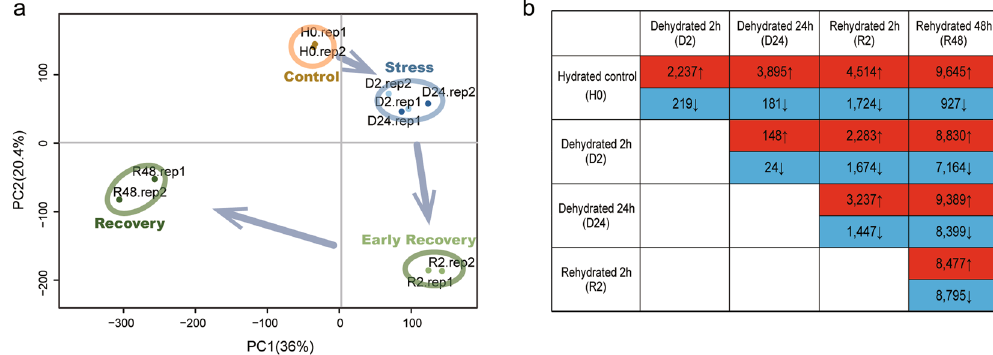
Figure 1. Global gene expression characteristics of Bryum argenteum during dehydration and rehydration. ( a ) Principal components analysis (PCA) of the biological replicates of desiccation-tolerant bryophyte Bryum argenteum subjected to well-watered conditions (control), after dehydration for 2 h and 24 h (stress) and recovery from dehydration for 2 h (early recovery) and 48 h (recovery). The arrows indicate the hydration process directions and transcriptomes from the same hydration stage were shown as dots of the same color. ( b ) Number of transcripts showing up- or down regulation during dehydration and